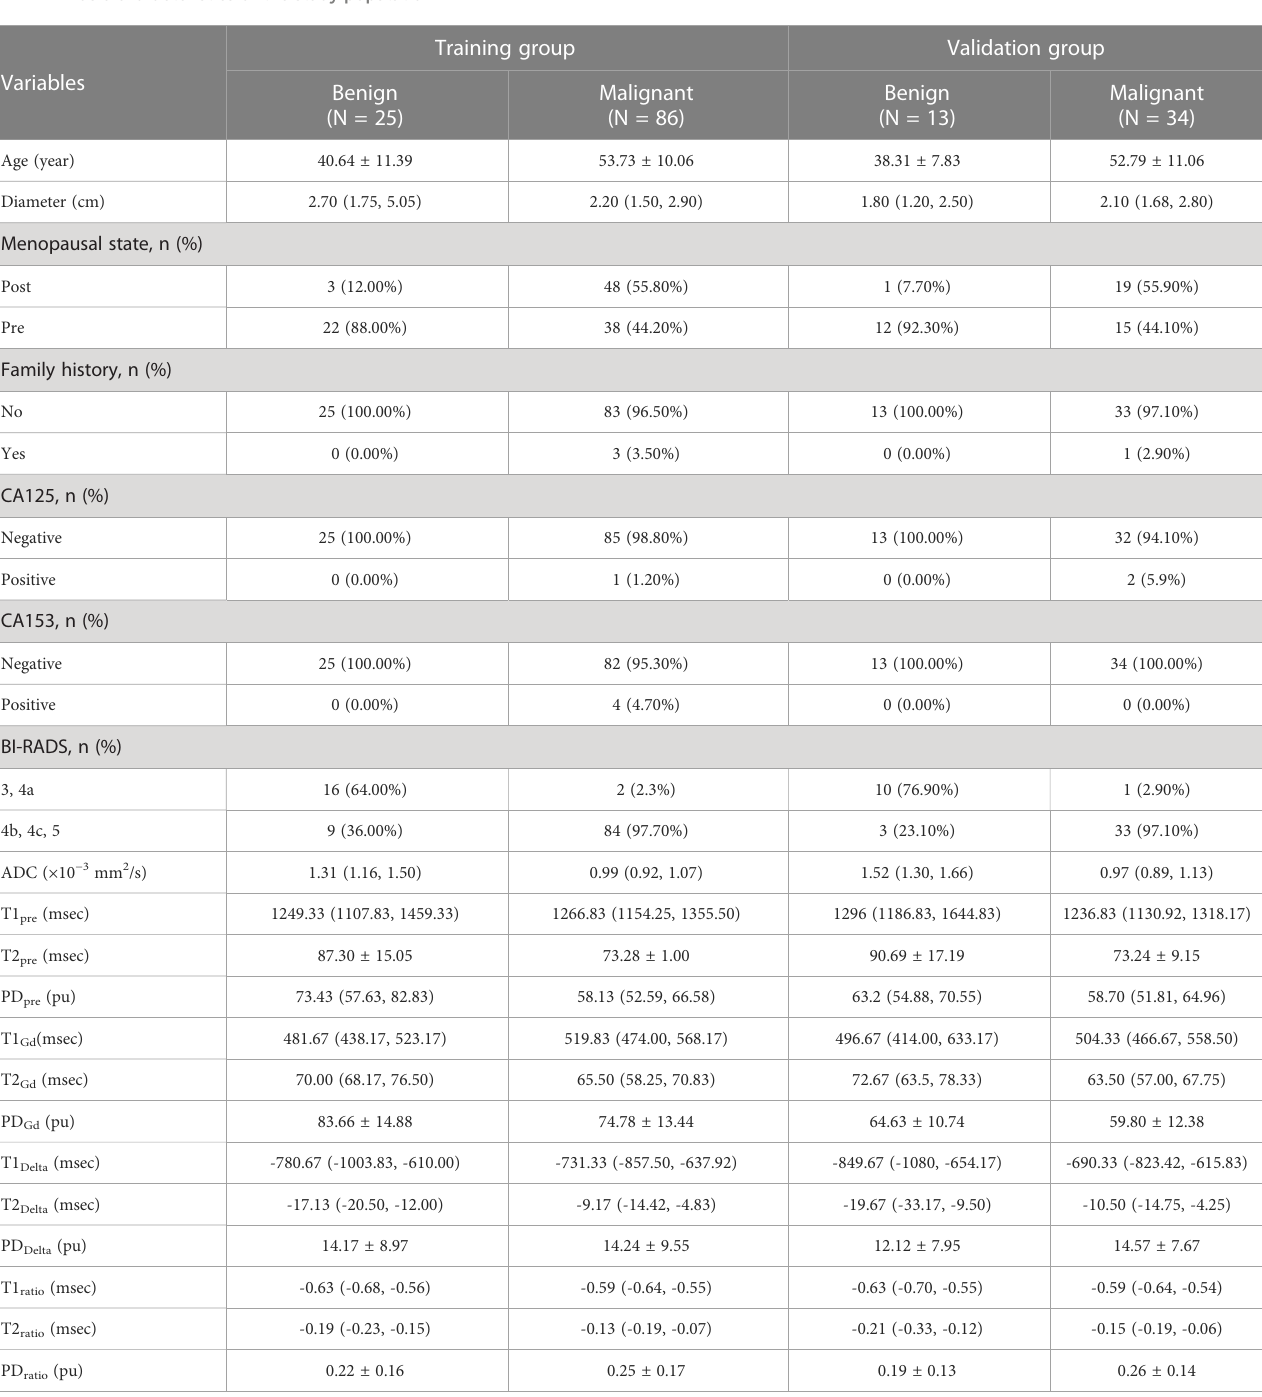
Training group Validation